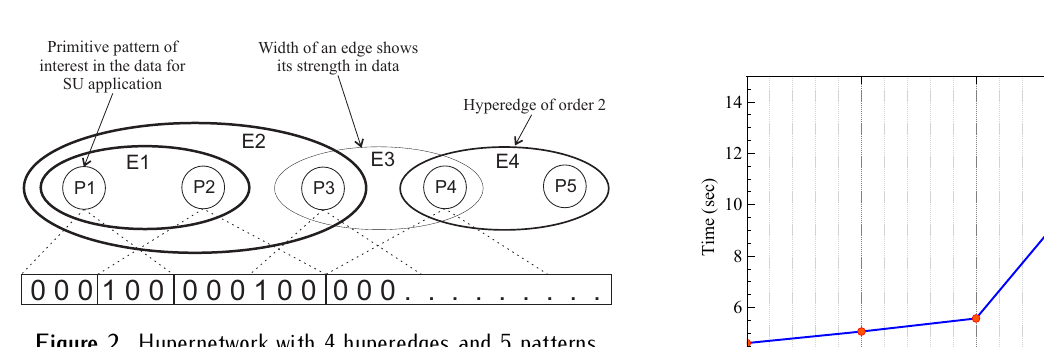
levels of the PU channel access. With such a reduced time-scale of the spectrum sensing, the usefulness of detected idle instances of the PU channel also reduces. This aspect is highlighted in Fig. 3 which shows the over two GSM channels having fixed PU duty cycles of 70 and 40 percent respectively. The x-axis shows the same duty cycle mapped on to di ff erent time